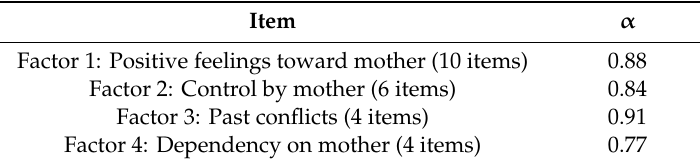
Table 2. Mother-daughter relationship scale: factor analysis results ( n = 329).